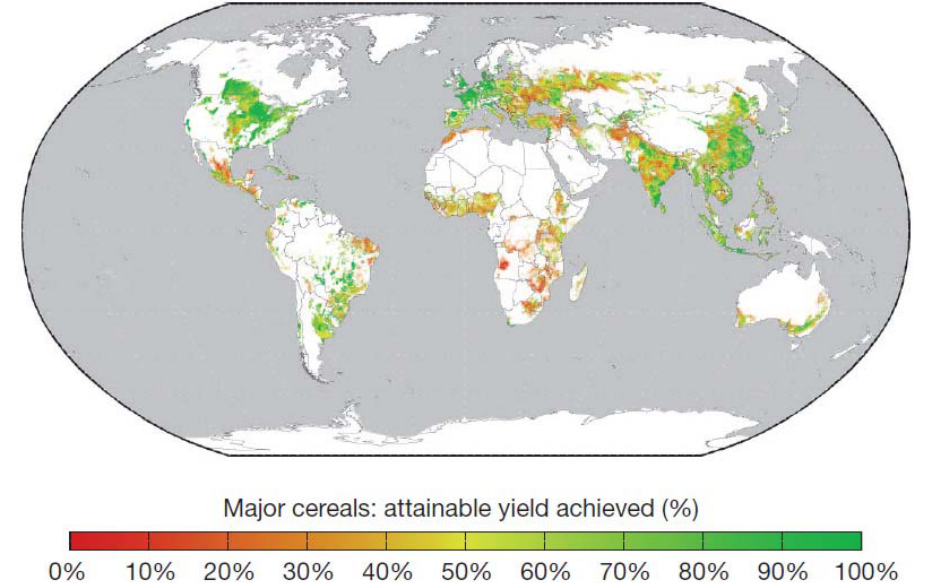
Figure 4. Average yield gaps for major cereal crops, maize, wheat and rice